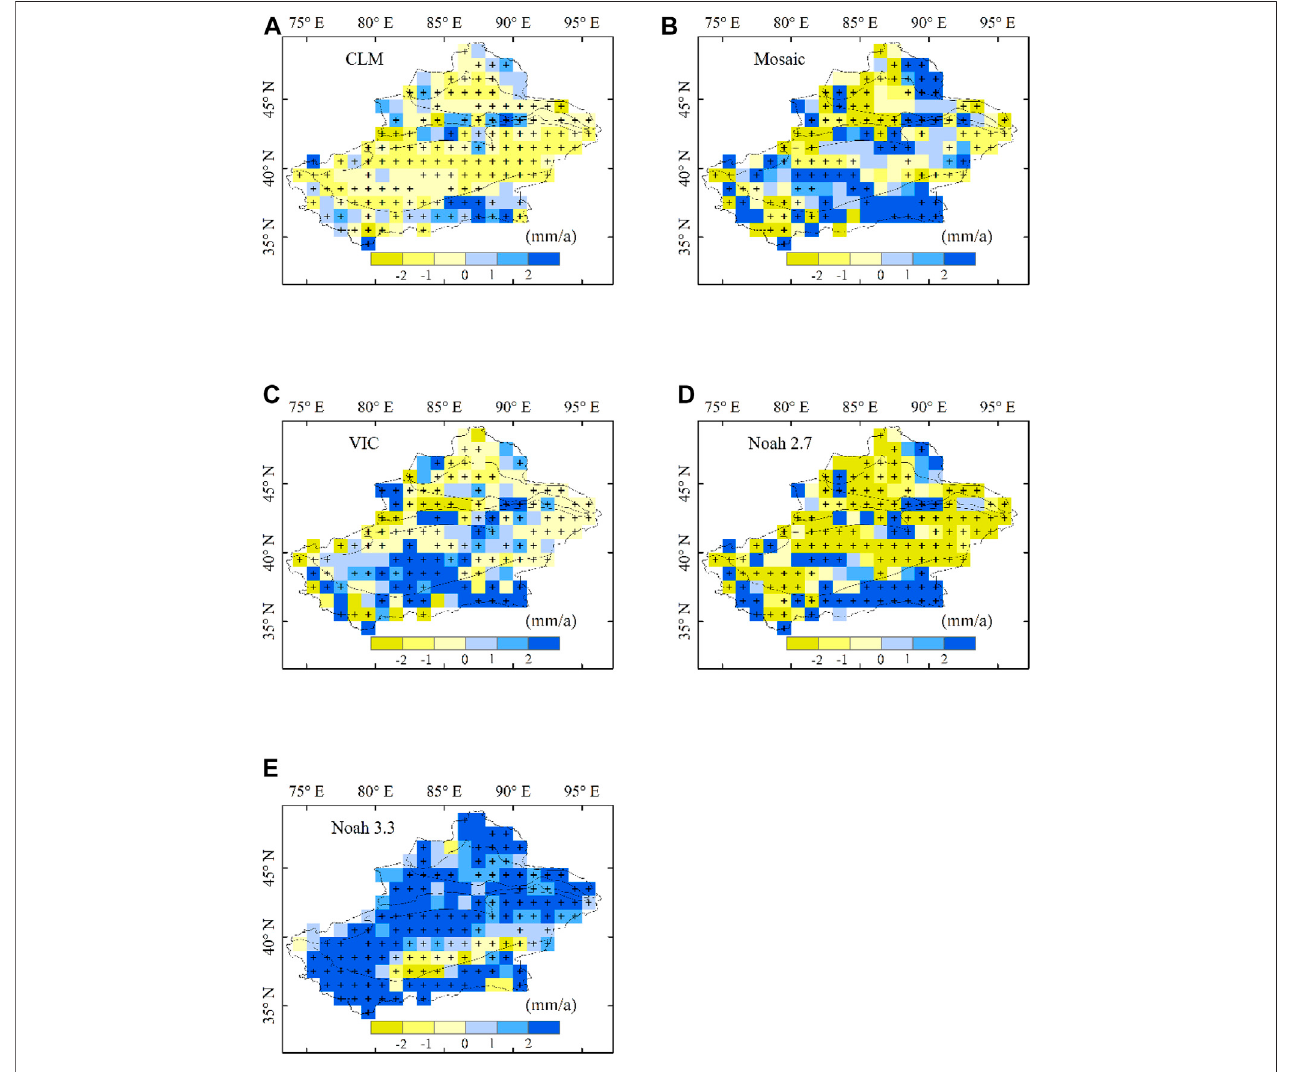
FIGURE 4 | Spatial distributions of the linear trends (mm/month) of the annual soil moisture for fi ve models during 2000 – 2017, (A) CLM, (B) Mosaic, (C) VIC, (D) Noah 2.7 and (E) Noah 3.3. The cross signs denote the trends are signi fi cant at the 95% signi fi cance level.